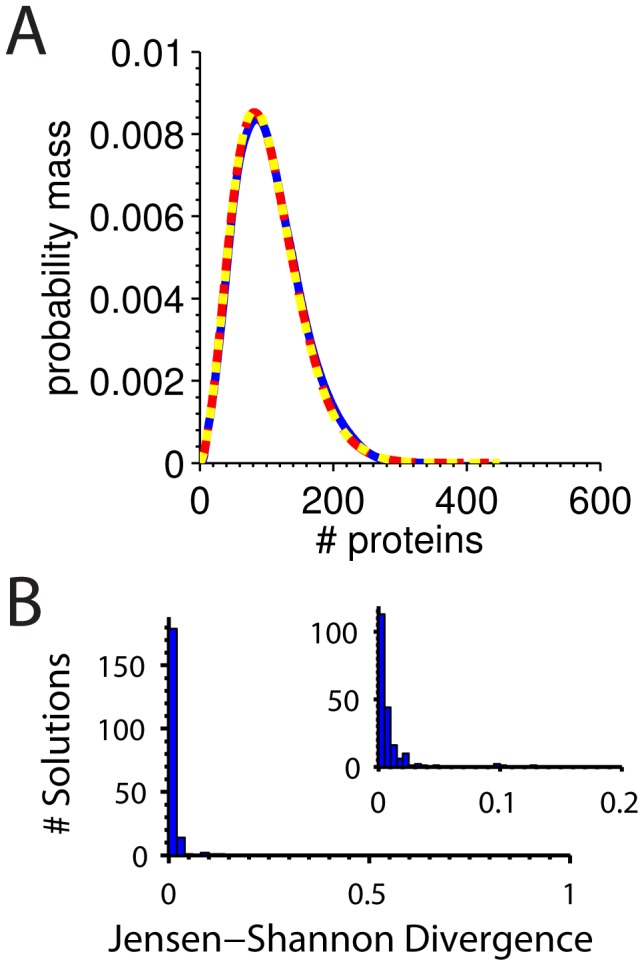
Distributions that correspond to CDRC sets with identical moments.
A Two CDRC solution sets maximally different from one another in log-Euclidean space are plotted in (solid) blue (, , , , , ) and (long-dashed) red (, , , , , ). These candidate CDRC solution sets map from ACES fitting of library member 6328, plotted in (short-dashed) yellow from CDRC set (, , , , , ) B Distribution of Jensen-Shannon divergences of maximally-distant CDRC candidate solution sets from their reference CDRC input set. (Inset) Zoom on the x-axis.